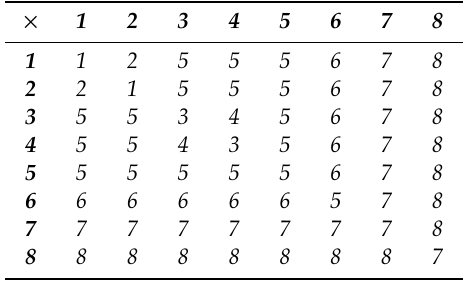
Table 14. The operation × on S